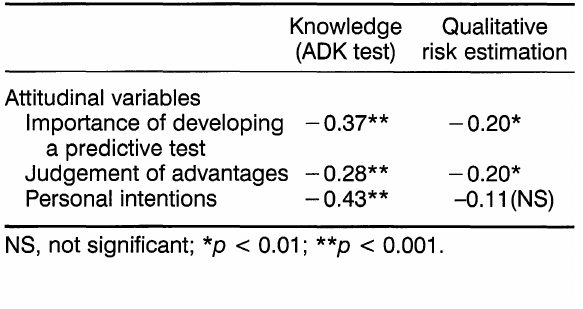
TABLE IV. Pearson correlations of the attitudinal variables